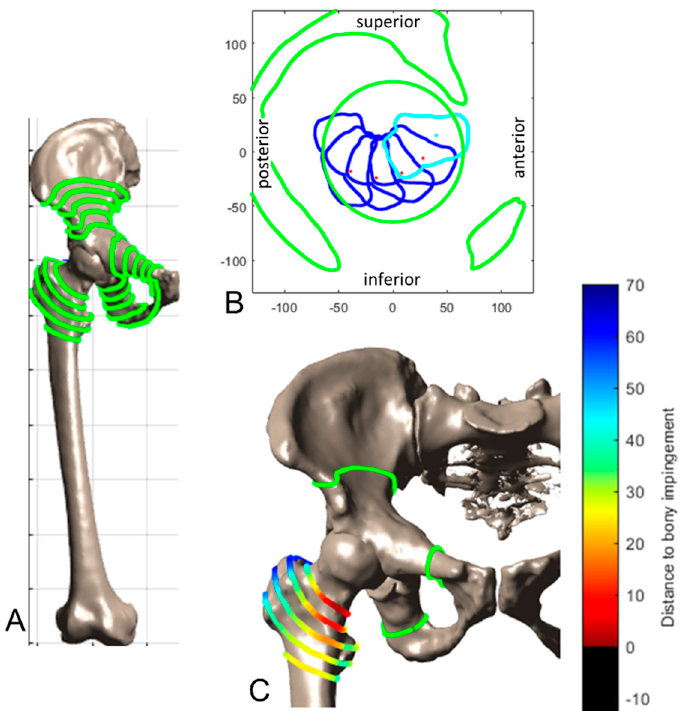
Figure 4. 3D and 2D visualization of possible impinging points (PIP). ( A ): The PIPs are depicted in green on the femur and pelvis. ( B ): 2D mapping containing the cup and pelvic limits (green) for an exemplary flexion motion of the femur (blue). ( C ): The femoral PIP color-coded by the minimal distance to impingement.